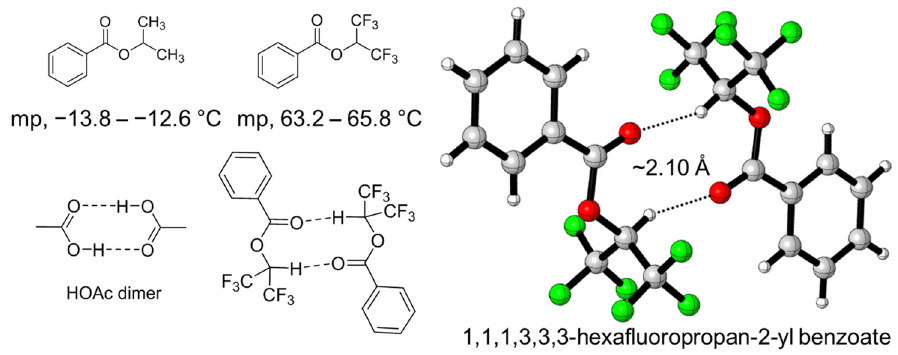
Figure 5. HFIPBz dimer observed by single-crystal X-ray diffraction, the measured melting point of HFIPBz and isopropyl benzoate.